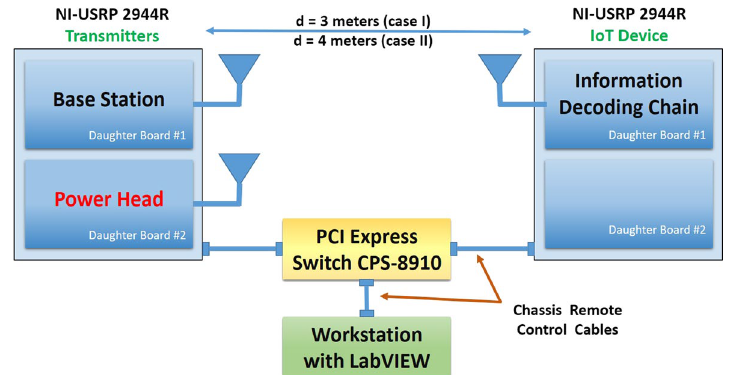
Fig. 15 Block diagram that illustrates the measurement setup